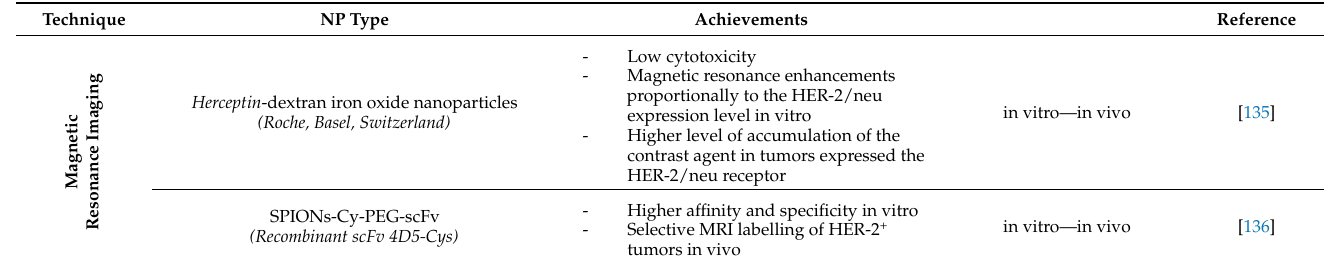
Table 3. Summary of all significant examples of NPs developed for HER-2 + BC diagnosis.